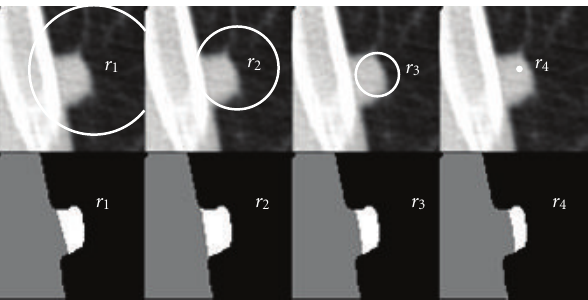
Figure 11: Example of forward search algorithm showing the central slice of a nodule, with the top row of images displaying several di ff erent radii of the region excluded from the subset of pleural surface points, and the bottom row of images displaying the resulting segmentations. Radius r 2 contains the largest set of pleural surface points without including nodule surface points; including too many or too few points negatively a ff ects the